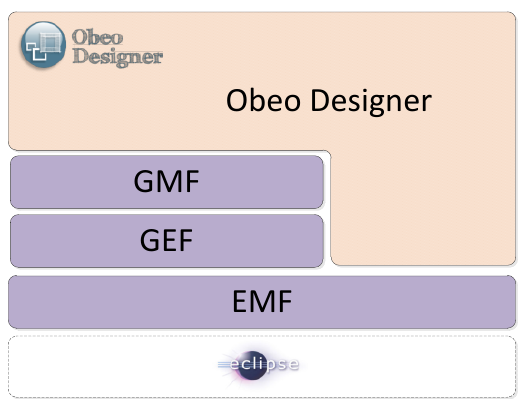
Figure 16. Obeo Designer architecture.